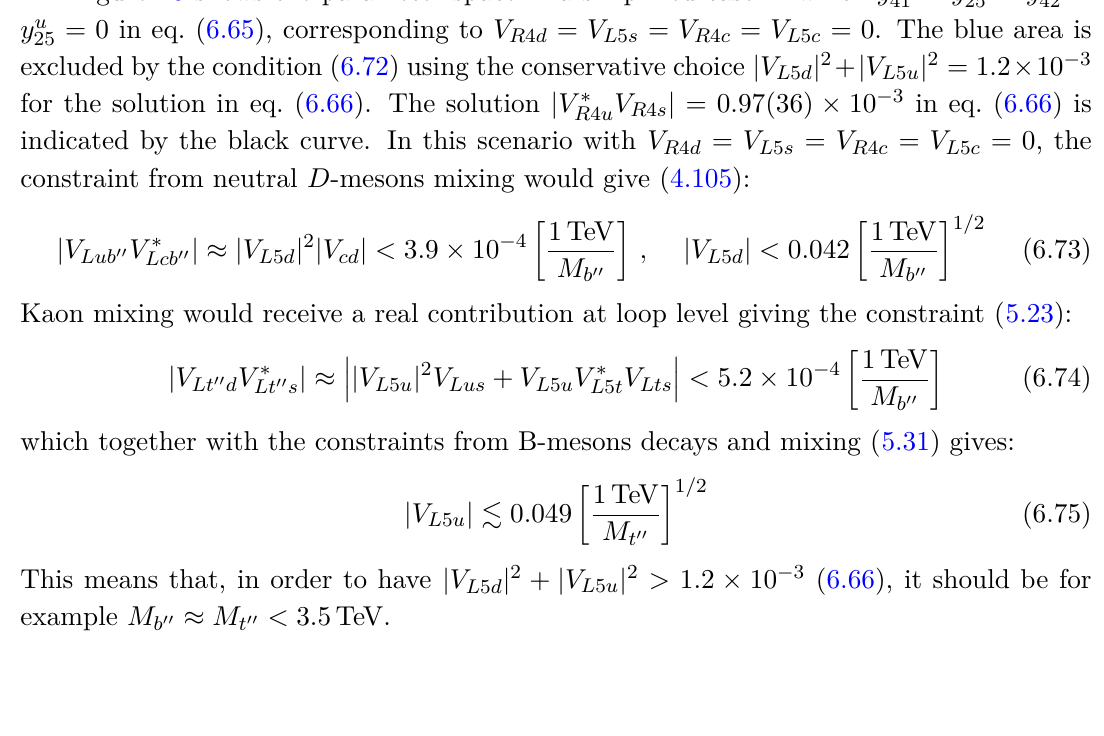
V R 4 s | = 0 . 97(36) × 10 − 3 in R 4 u